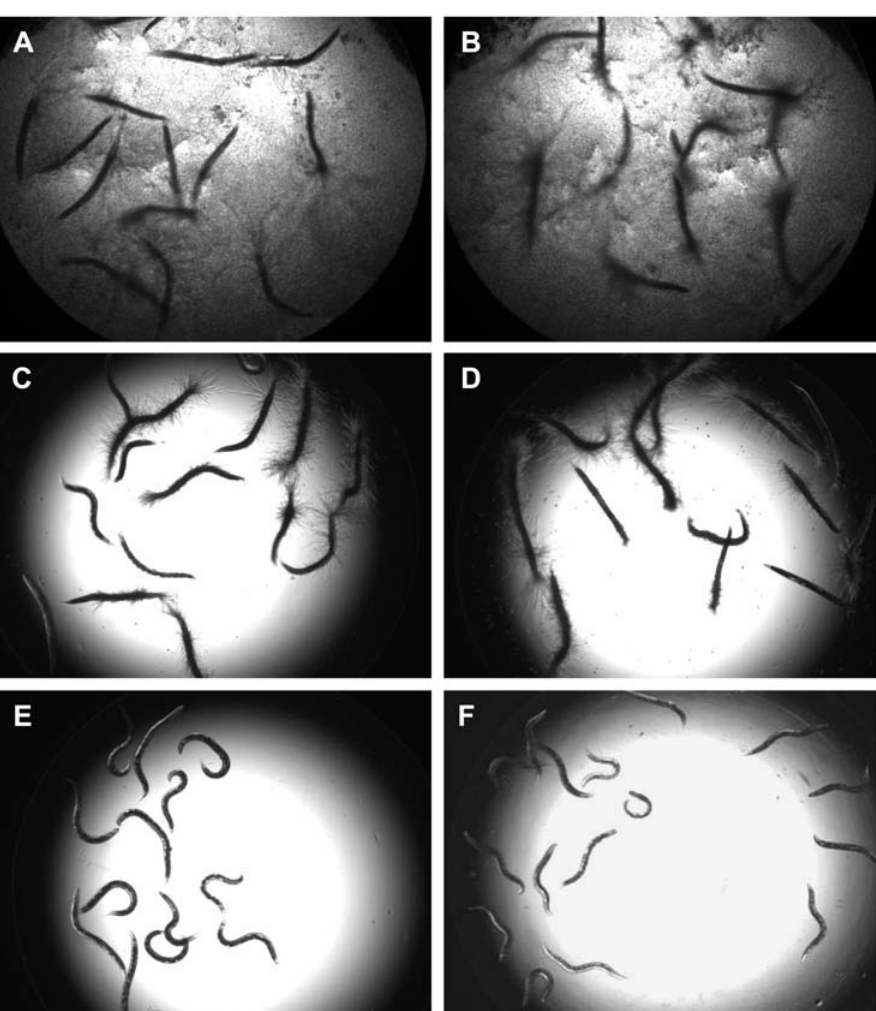
Figure 2. Representative assay wells from the C.elegans - C.albicans antifungal compound screen. (A) Negative control (DMSO added); (C) and (E) Amphothericin B was added as a positive control at either 1.0 m g/mL (C) or 2.5 m g/mL (E); (B,D,F) Screened compound (in this case ketoconazole) exhibiting no antifungal activity (2 m g/mL; (B)), in vitro antifungal activity (4 m g/mL; (D)), and in vivo antifungal activity conferring C. elegans survival (8 m g/mL (F).